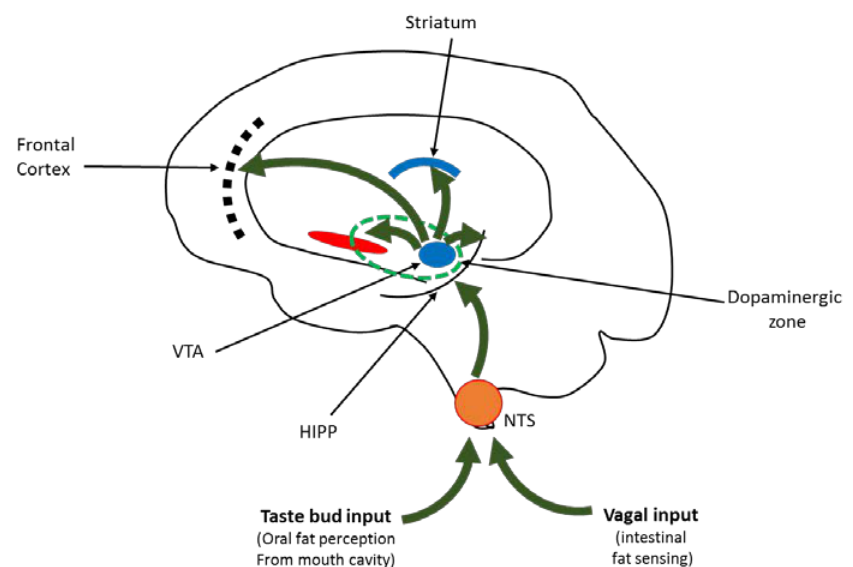
Figure 2. Relationship of food intake and reward pathway. The figure shows that the gustatory memory for fat and its implication would depend on the cues coming from taste bud cells, localized in the lingual papillae, and vagal nerve information from intestinal lipid sensing. Both kinds of information will ascend to di ff erent parts of the brain via NTS. Hippocampus will be involved in the learning of palatability of fat, and communicate to VTA which is sending its a ff erences to frontal cortex, straitum and other parts of the brain. Indeed, the dopaminergic zone covers VTA and NA. NTS: nucleus tractus solitaris; HIPP: hippocampus; VTA: ventral tegmental area .